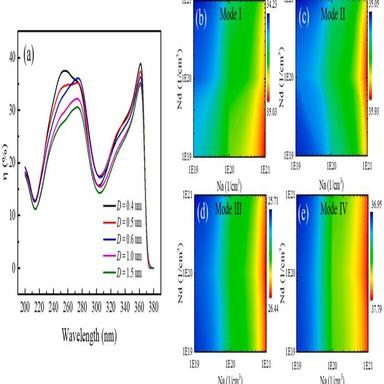
(a) Electrical anisotropy η of MGPIN with different depths of intrinsic region of GaN PiN structure. The mapping of electrical anisotropy η of MGPIN of (b) mode I, (c) mode II, (d) mode III and, (e) mode IV with different concentrations of p- and n-layers.